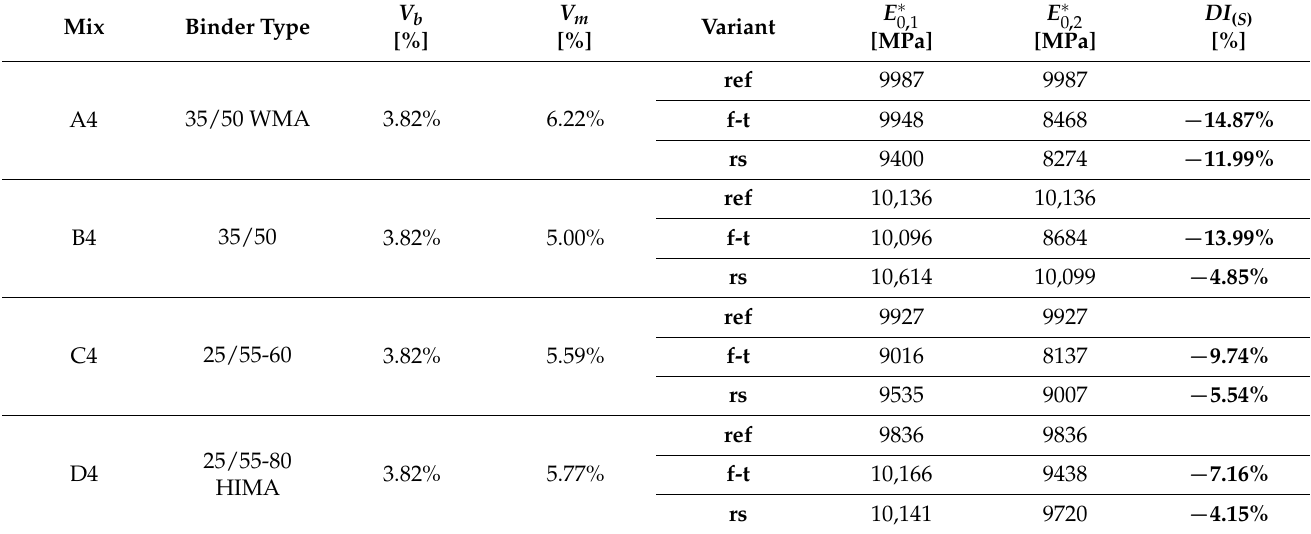
Table 3. Comprehensive test